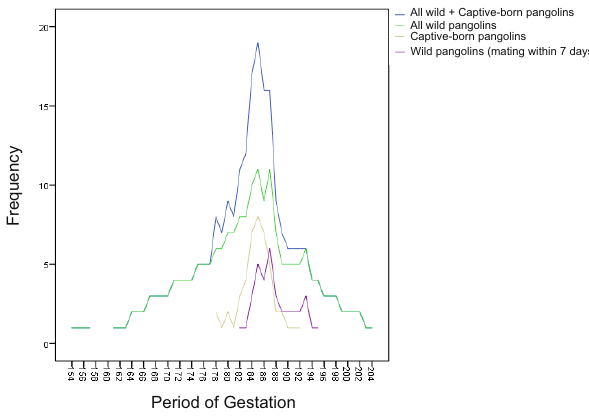
Fig. 4 Analysis of gestation length in pangolins. Comparison of the gestation length for different groups of female Malayan pangolins ( M. javanica